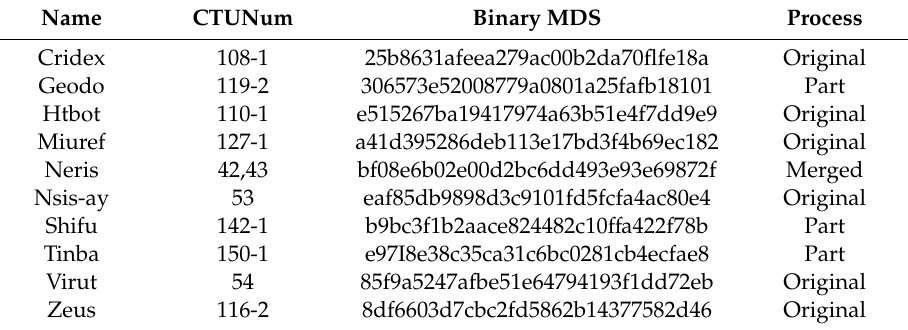
Table 1. USTC-TFC2016 malware tra ffi c.